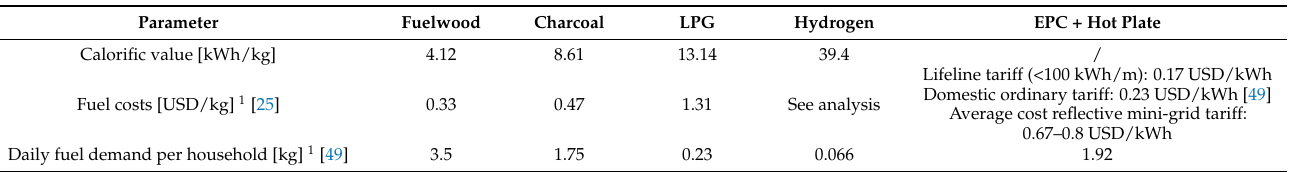
Table 2. Typical cooking fuel parameter applied in this analysis [25,30]. The annual fuel demand per household is calculated based on the simplified assumption that only one fuel exclusively is used as cooking fuel, neglecting fuel